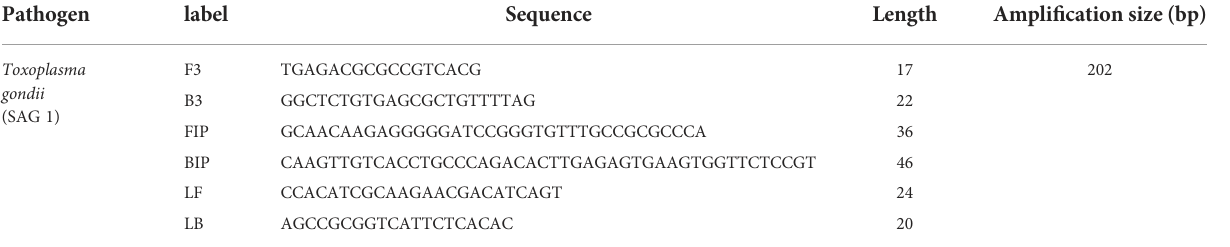
TABLE 1 T. gondii -speci fi c primer sets used in this study. Pathogen